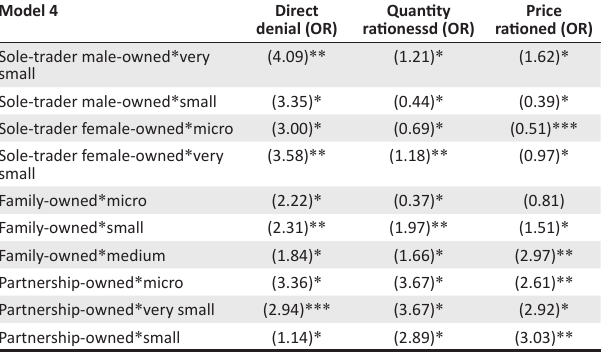
TABLE 4: Small, micro and medium enterprise interaction structural effects on type of credit rationing of small, micro and medium enterprises. Model